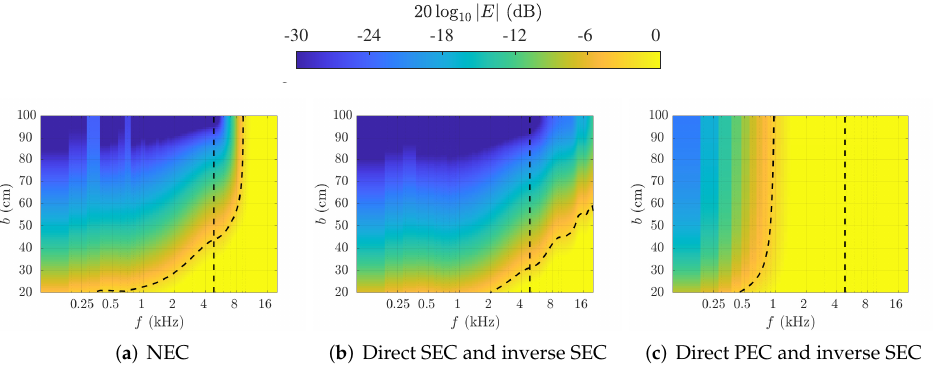
Figure 7. Comparison of performance with synthesis error (20) in dB ( P = 252, q = 5, N g = 14). ( a ) synthesis with NEC. Panel; ( b ) synthesis with direct and inverse SEC; ( c ) synthesis with direct PEC and inverse